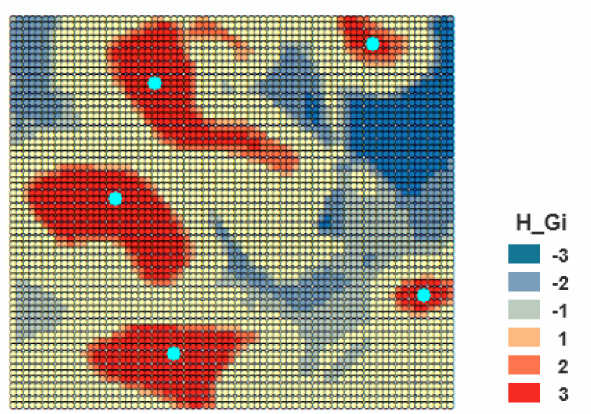
Figure 11. The distribution map for the first dataset using our proposed